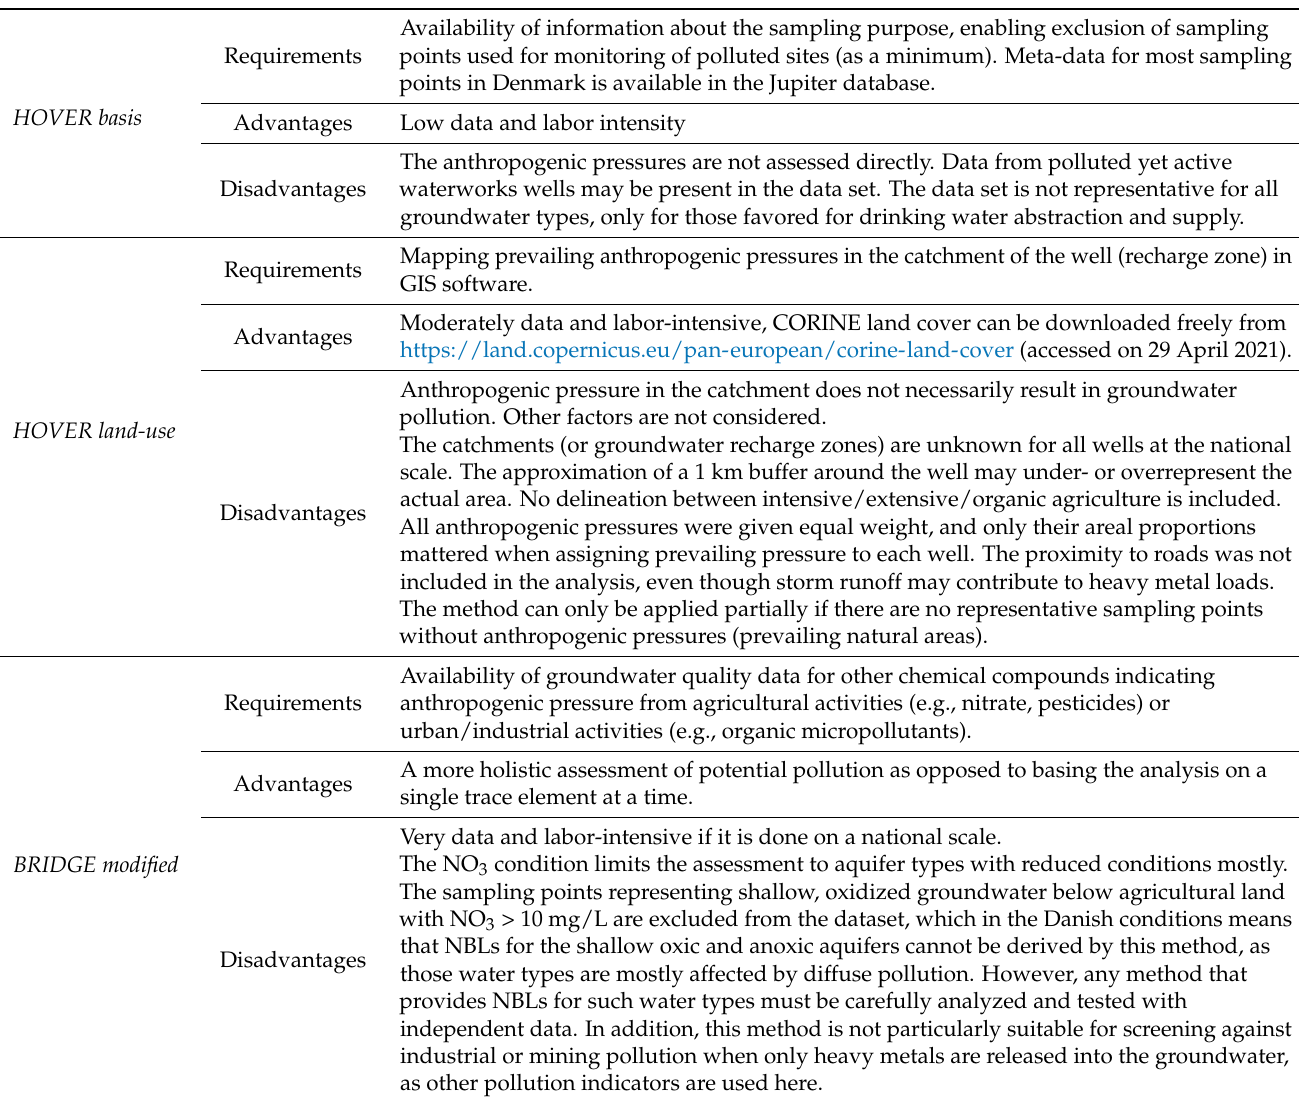
Table 4. Comparative analysis for HOVER basis , HOVER land-use, and BRIDGE modified